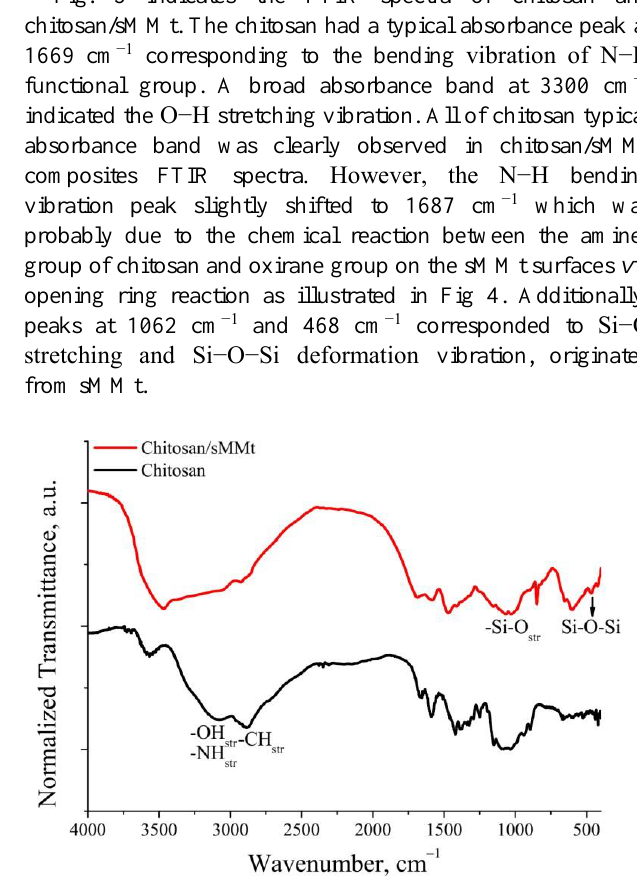
Fig. 5 FTIR spectra of chitosan and chitosan/sMMt